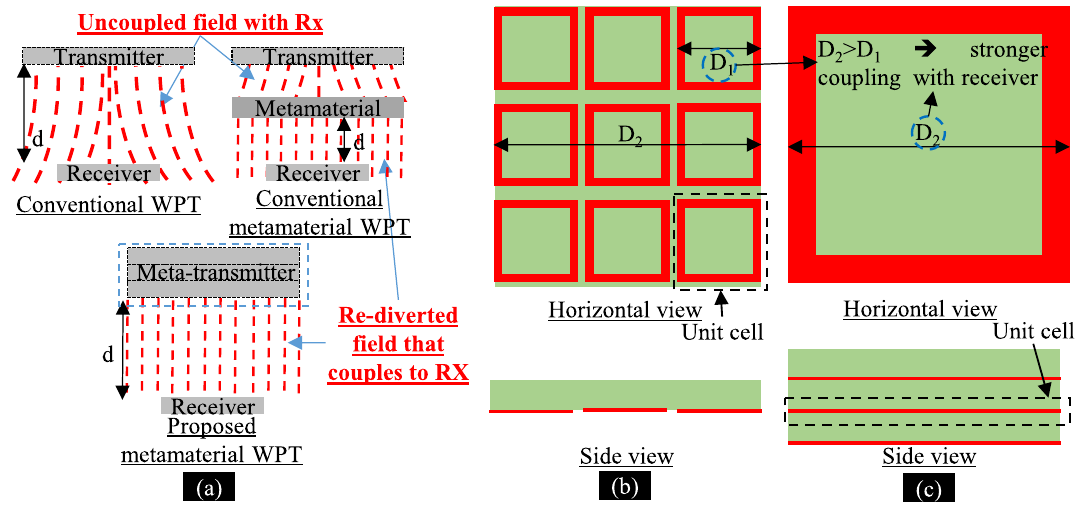
Figure 1. Near-Zero metamaterial. (a) Conventional and proposed WPT systems. (b) Conventional planar metamaterial in 3 × 3 array configuration. (c) Proposed metamaterial inspired geometry in co-axial